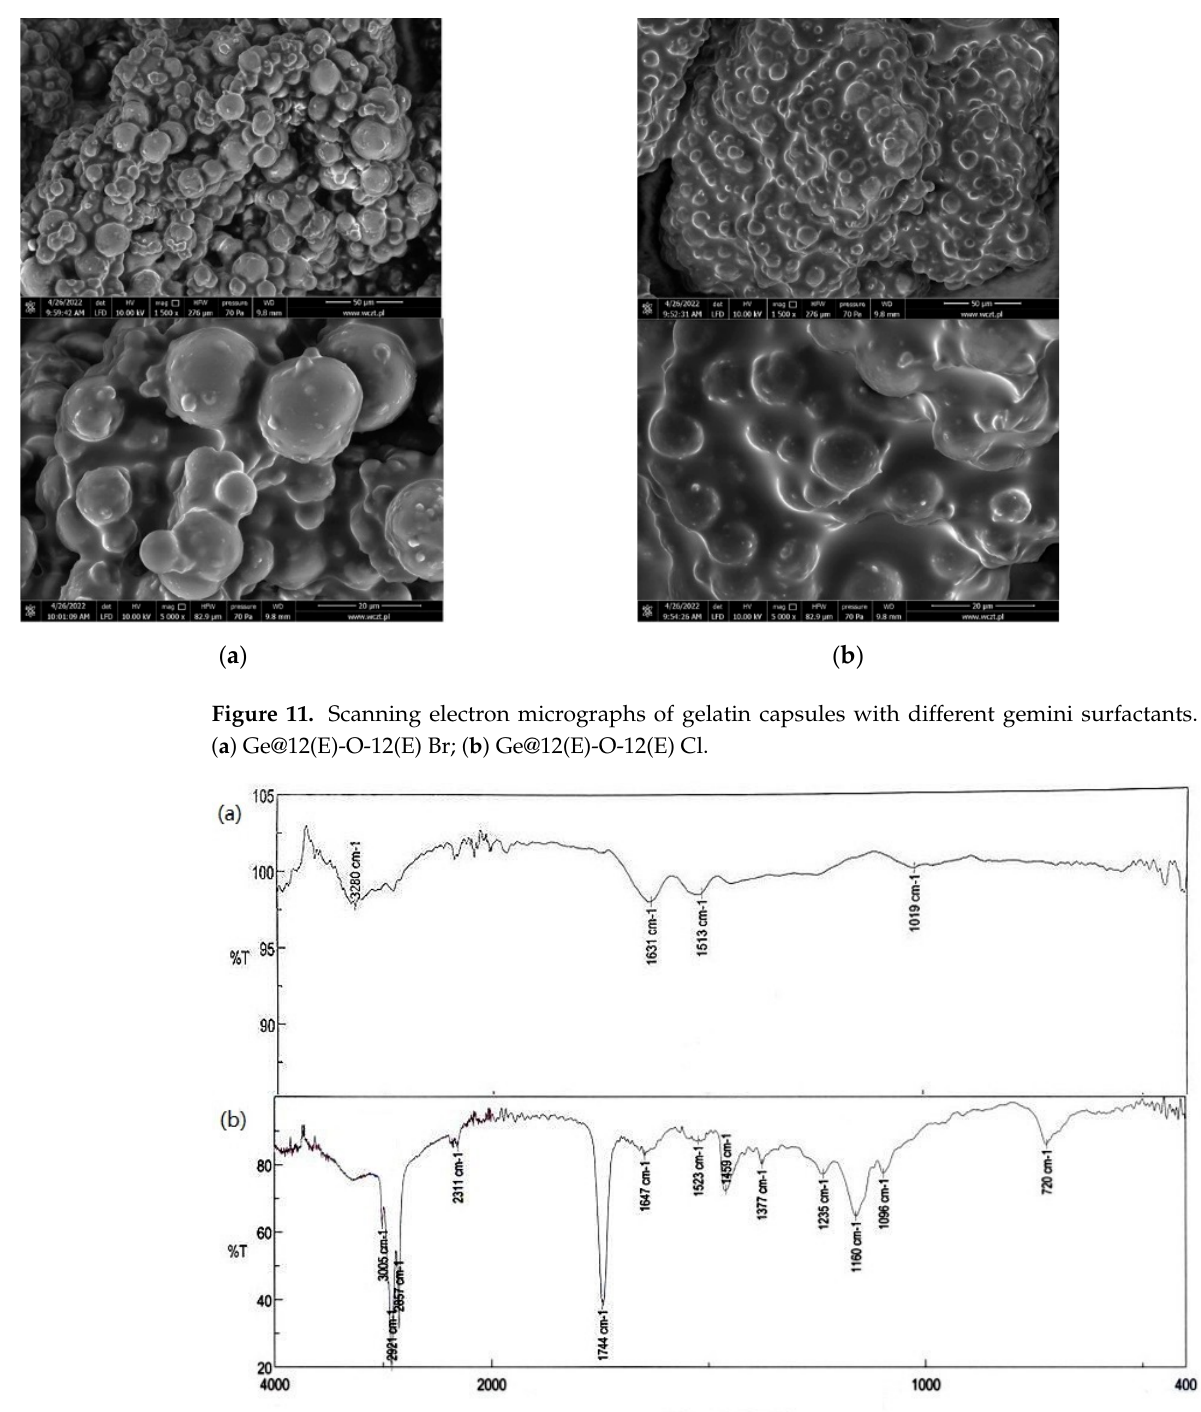
Figure 12. FTIR spectra of gelatin capsules without and with the gemini surfactants. ( a ) Ge@empty;